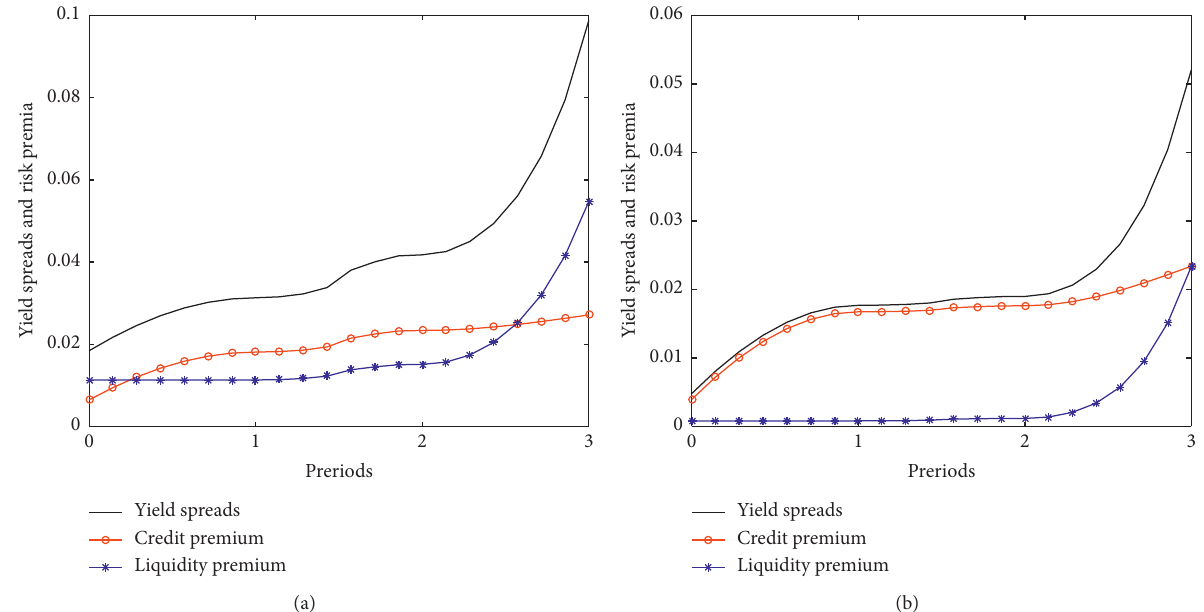
Figure 5: Yield spreads and risk premium in liquidity-leading crisis (investment-grade/speculative-grade